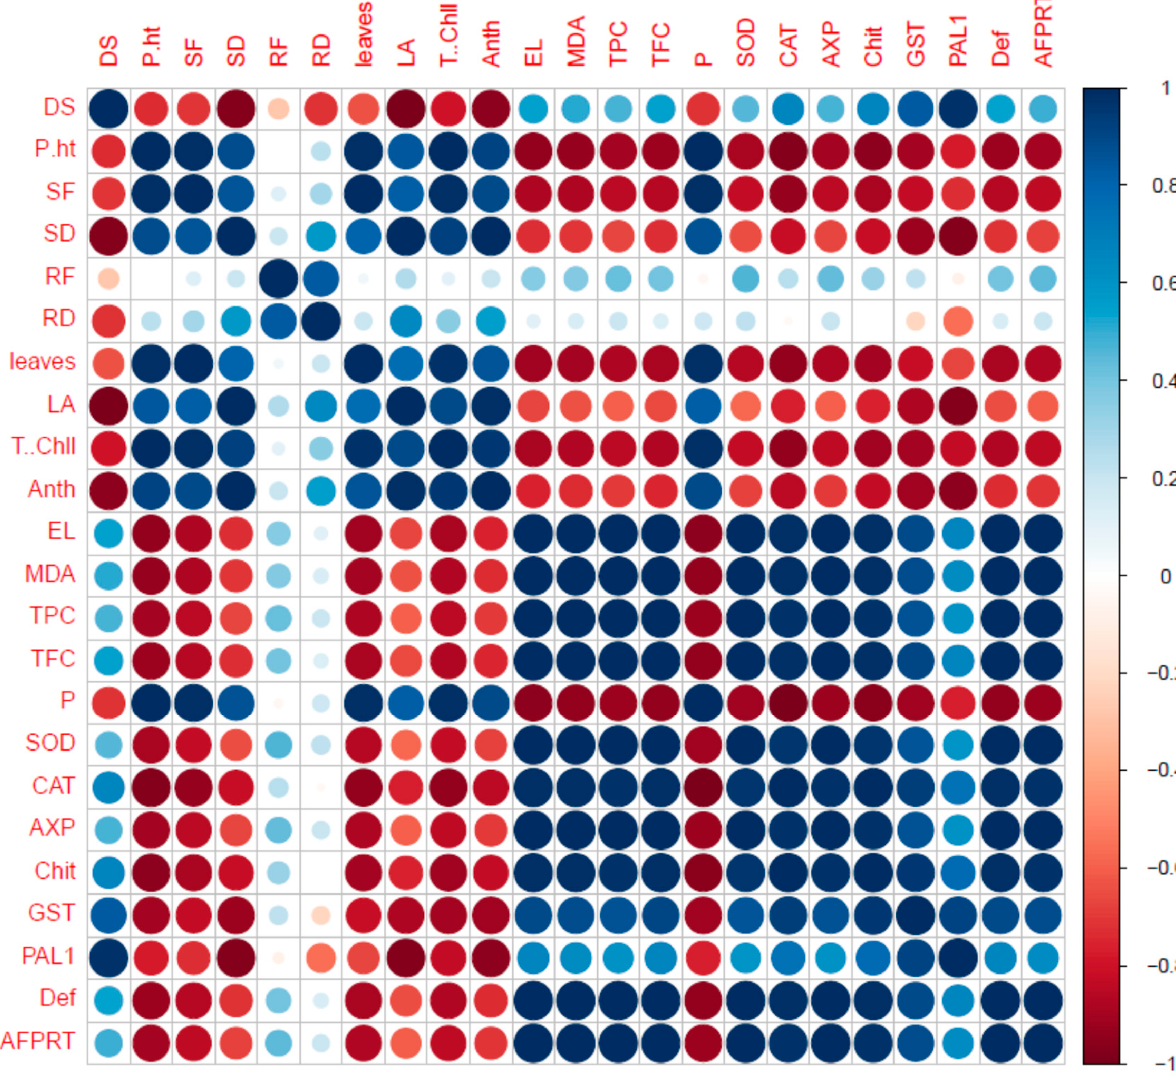
Figure 6. Correlation analysis among different parameters plant grown under different treatments. Concurrently, we also performed a PCA analysis to identify the relationships among the variables under different treatments. Correlations between variables were detected via biplot analysis, where an acute angle indicates a positive relationship, and an obtuse angle a negative one; a right angle indicates no correlation. Altogether, both PCs explain 96.3% of the total variance of all the analyzed variables, where PC1 has the largest variance due to its orthogonal transformation. According to the PCA calculated for the experiments, PC1 explains 79.4.6% of the total variance of the variables, while the second factor (PC2) explains about 16.9% (Figure